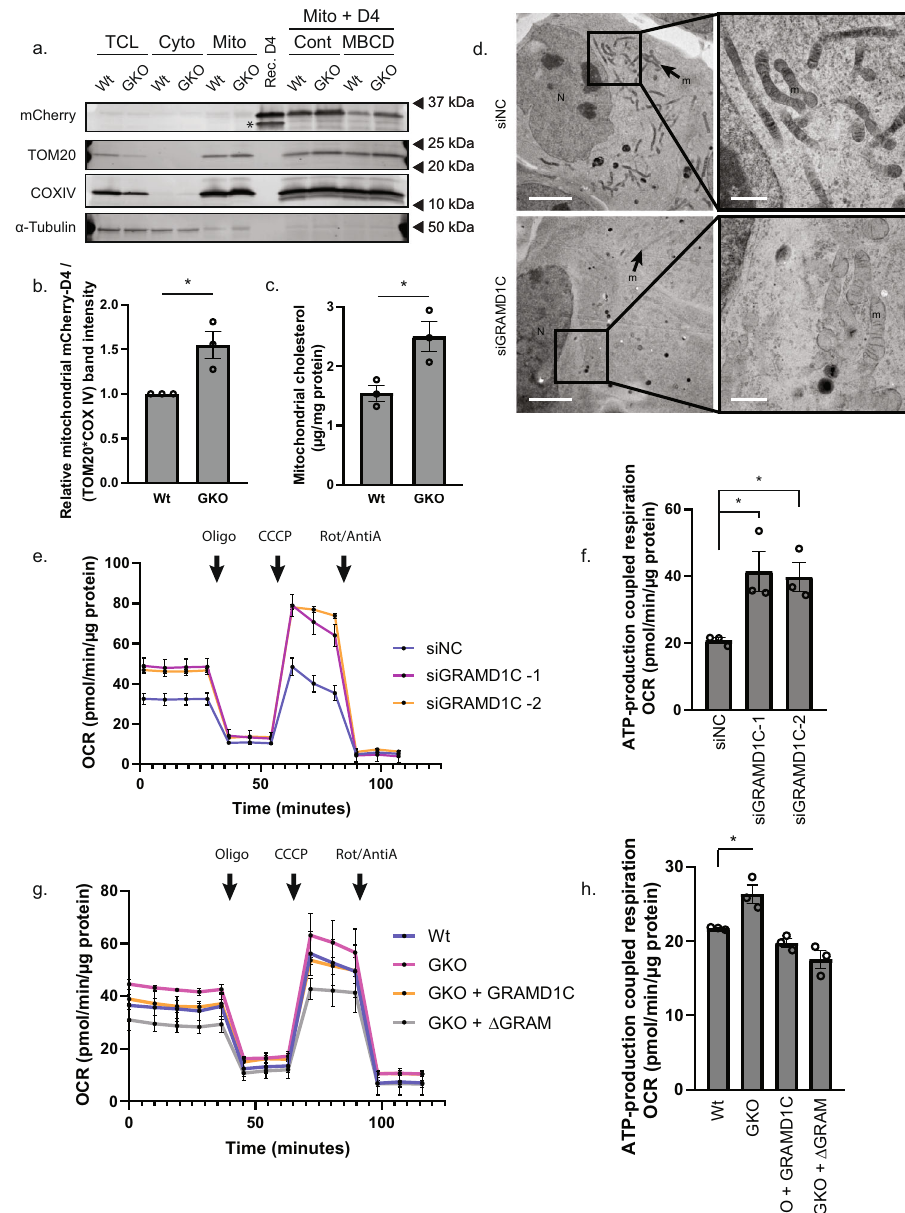
Fig. 6 | GRAMD1C regulates mitochondrial bioenergetics. a Wt and GRAMD1C knockout (GKO) cells expressing 3XHA-EGFP-OMP25 were subjected to mito- chondria isolation from a total cell lysate (TCL). The isolated mitochondria were incubated with the cholesterol probe mCherry-D4 (recombinant protein shown in lane 7) in the presence or absence of methyl- β cyclodextrin (MBCD). The asterisk indicates free mCherry. b Quanti fi cation of mCherry-D4 band intensity in the iso- lated mitochondria fractions from a. relative to the average band intensity of the mitochondrialproteinsTOM20andCOXIVandnormalizedtoWtcells.Signi fi cance was determined using two-tailed Students T test from n =3 independent experi- ments.Errorbar=SEM. P value=0.0238. c MitochondriafromWtorGKOcellswere isolated and mitochondrial lipids were extracted. Absorbance changes corre- sponding to cholesterol abundance were normalized to mitochondrial protein concentration. Signi fi cance was determined using Student ’ s T test from n =3 independent experiments. Error bar=SEM. P value=0.0162. d Cells treated with control siRNA (siNC) or siGRAMD1C were treated to high-pressure freezing fol- lowedbyfreezesubstitution(1%OsO4,0.5%uranylacetate,0.25%glutaraldehydein